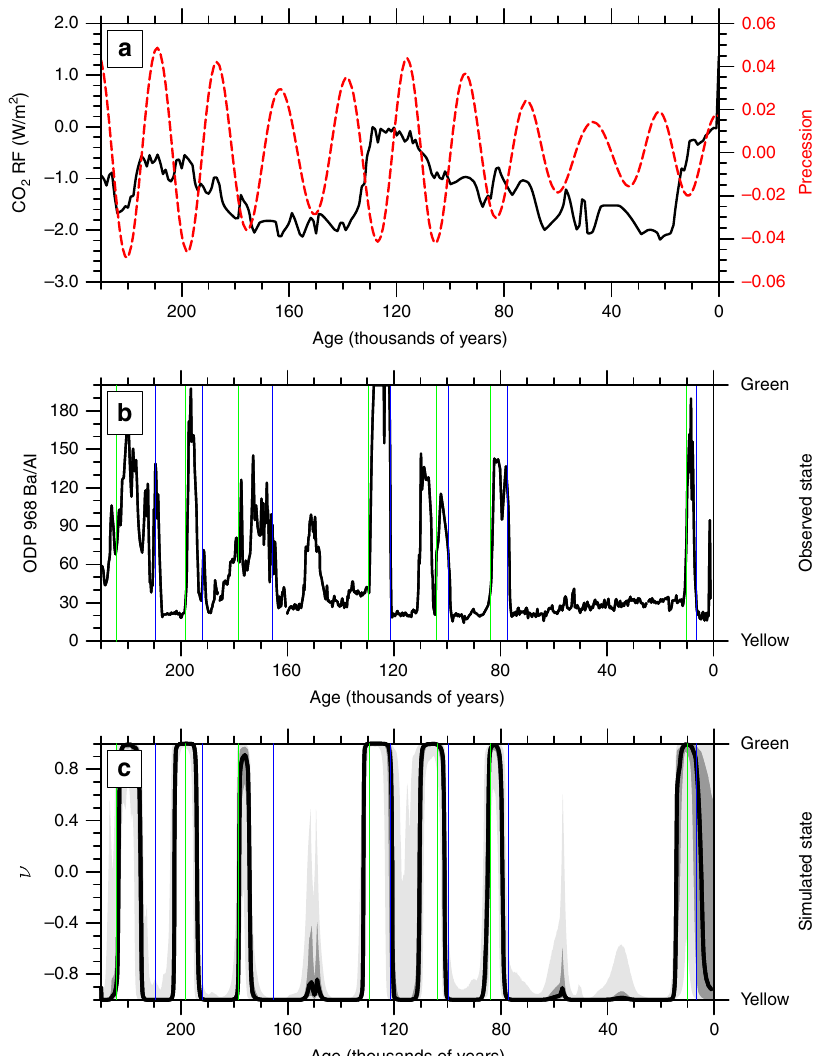
Fig. 4 The last two glacial cycles. a The input times series of radiative forcing of carbon dioxide changes 30 (black) and climatic precession 29 (red). b Barium to aluminium ratio at Ocean Drilling Program site 968 in the Eastern Mediterranean 24 . c The distribution of the roughly 12,000 ensemble members that exhibit seven ‘ green ’ events. The median (black), inter-quartile range (dark gray) and 5 – 95% range (light gray) are shown, along with the sapropel start (green) and end (blue) dates calculated from observations